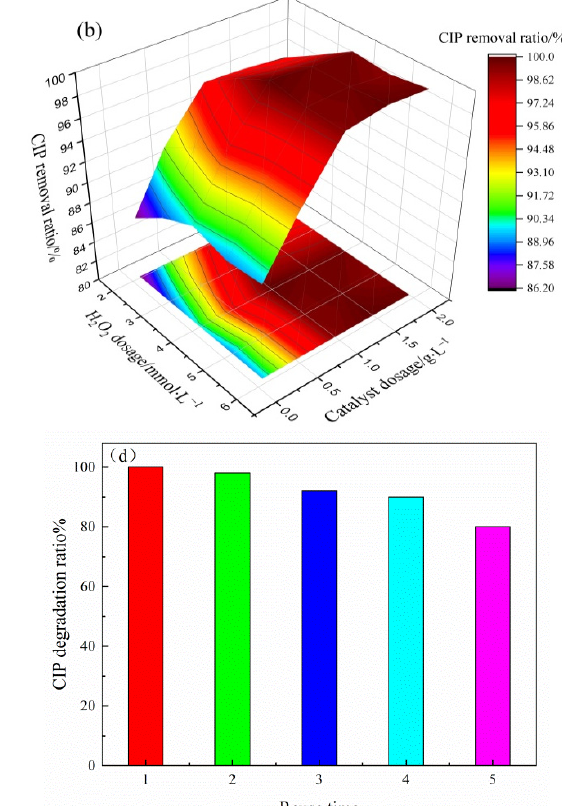
Figure 4. Effects of pH value ( a ), catalyst dosage and H 2 O 2 concentration ( b ); temperature ( c ) on the degradation of CIP by CuO/GO ‐ DE catalyst; the reusability of CuO/GO ‐ DE catalyst ( d ).